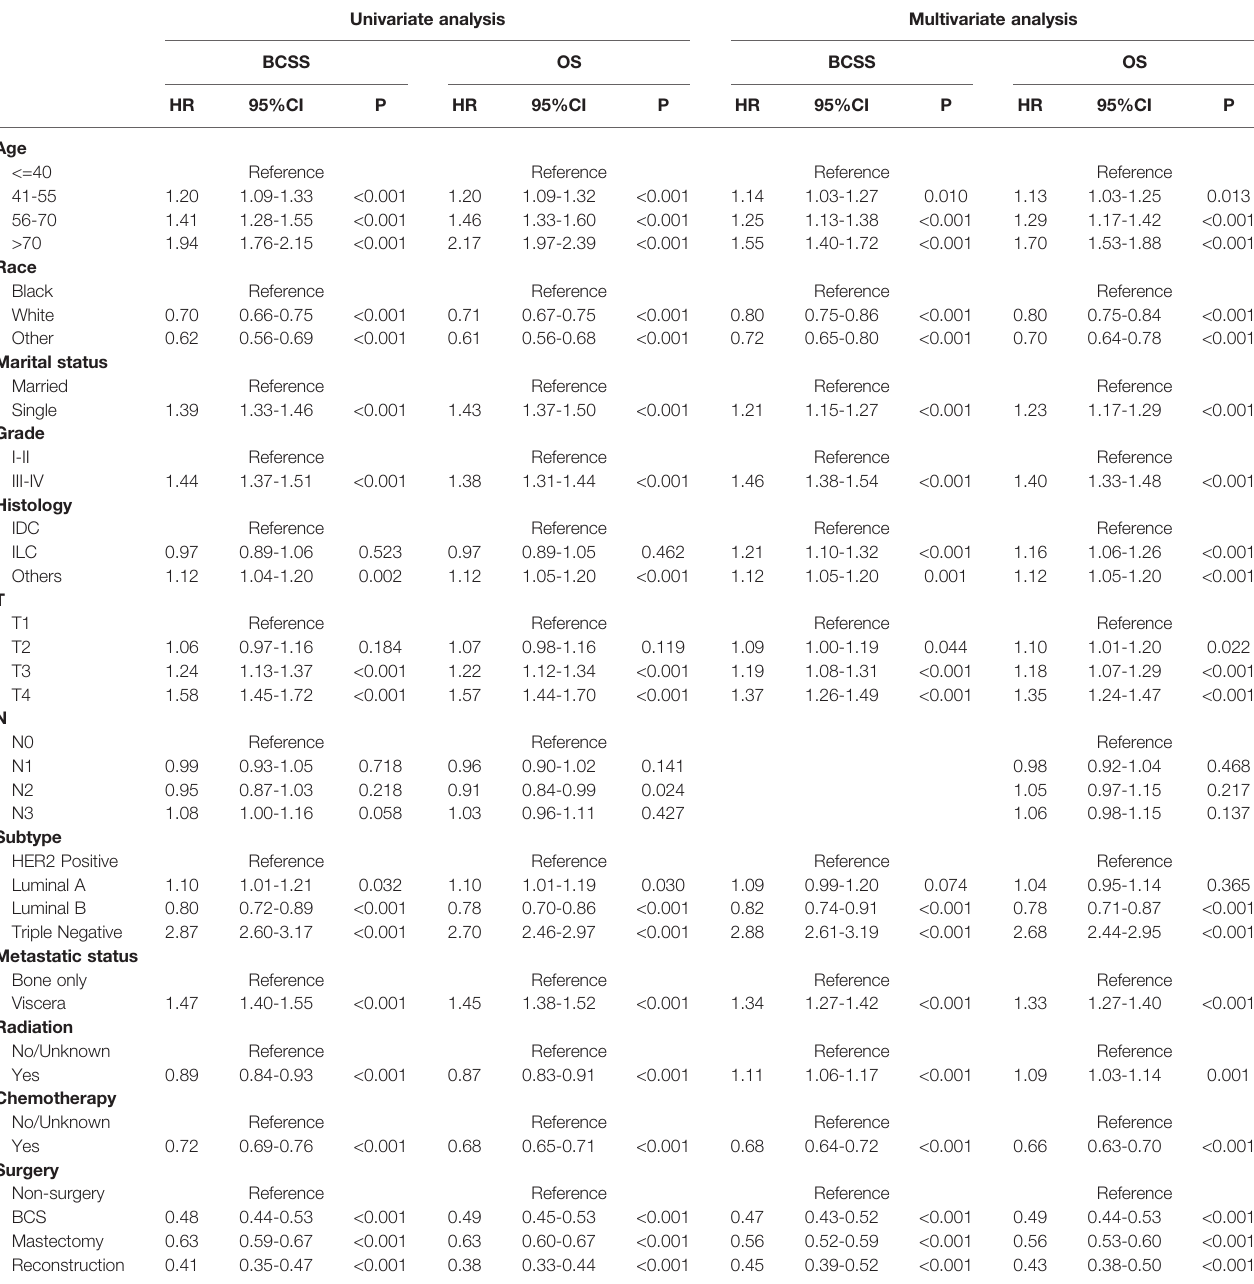
TABLE 2 | Univariate and multivariate Cox hazard proportional model analysis of de novo stage-IV BC patients. Univariate analysis Multivariate